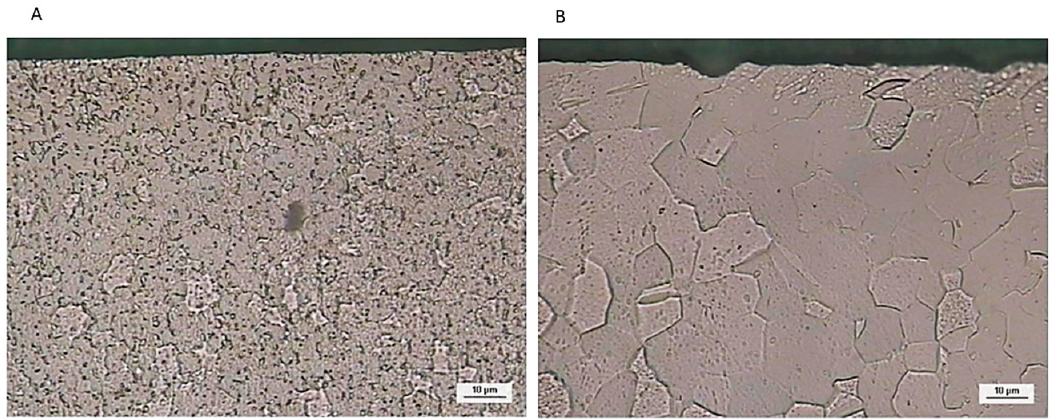
Figure 7. The grain sizes of the machined implant ( A ) and lasered implant ( B ).